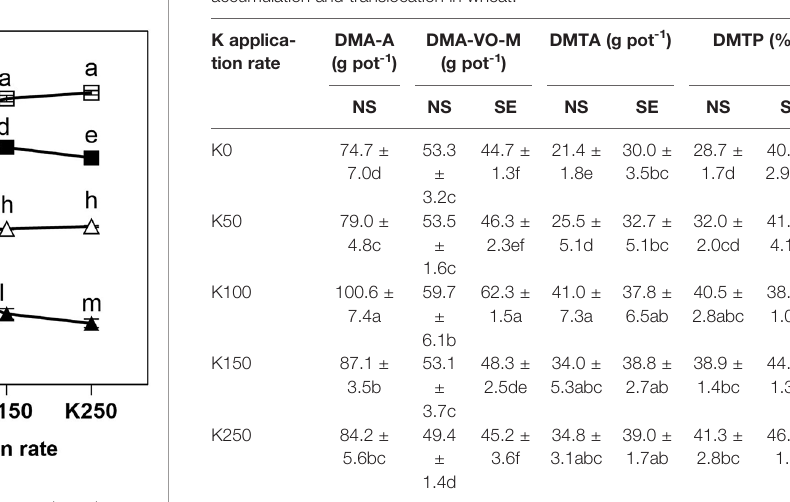
FIGURE 4 | The total soluble sugar content of winter wheat grain under different treatments. The error bars stand for standard deviations of the means of fi ve independent biological replicates. For each trait, different letters represent signi fi cant difference from each other according to three-way repeated measures ANOVA followed by least signi fi cant difference (LSD) multiple comparison ( P < 0.05). NS: no shading treatment; SE: shading from the 1st day to the 10th day after anthesis (shading at early fi lling stage for 10 days, SE); Five potassium rate: 0 (K0), 50 (K50), 100 (K100), 150 (K150), and 250 (K250) mg K 2 O kg -1 soil in the form of KCl.